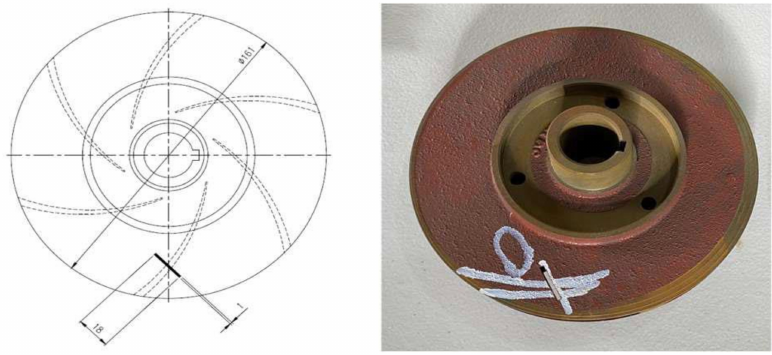
Figure 6. Impeller